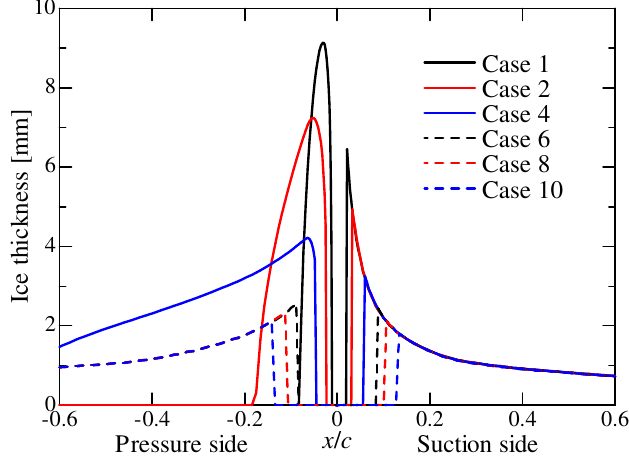
Figure 8. Formed ice